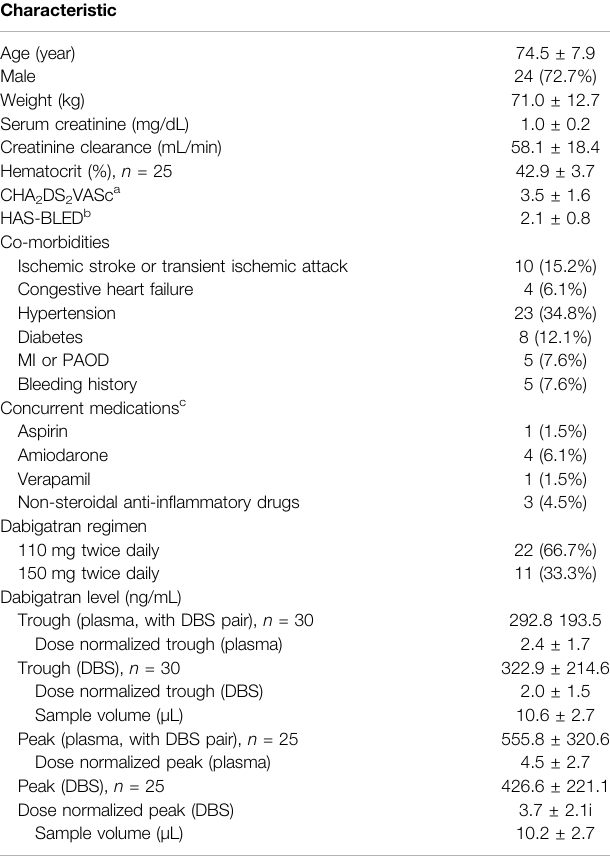
TABLE 1 | Demographic characteristics for the study